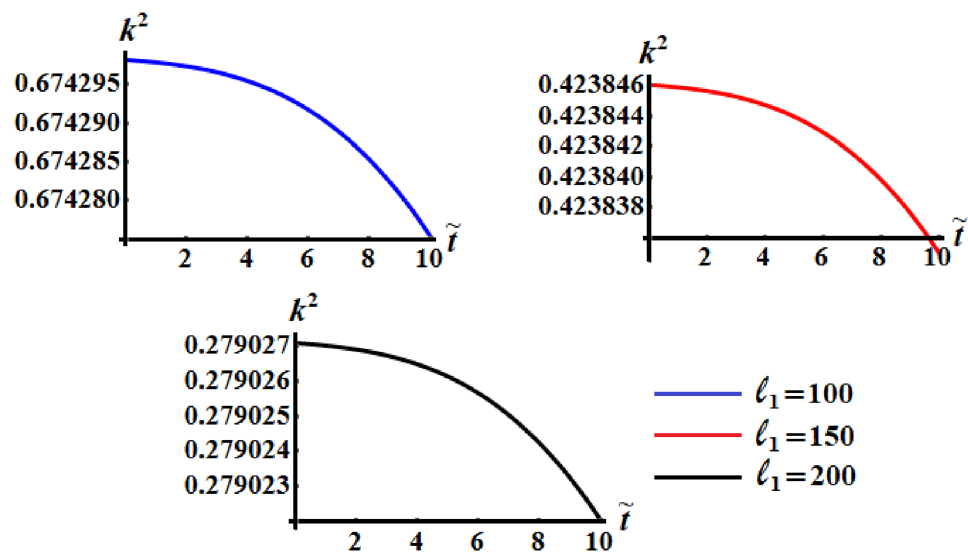
Figure 7. Demonstrates the variation of k 2 over time when (ℓ 2 , ℓ 3 ) = ( 150, 50 ) kg m 2 s − 1 at ℓ 1 ( = 100, 150, 200 ) kg m 2 s − 1